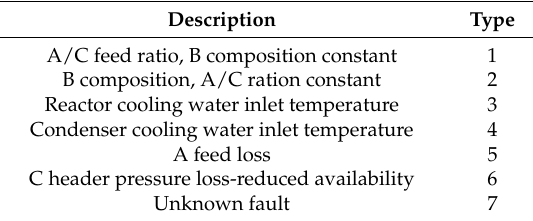
Table 1. Description of fault.